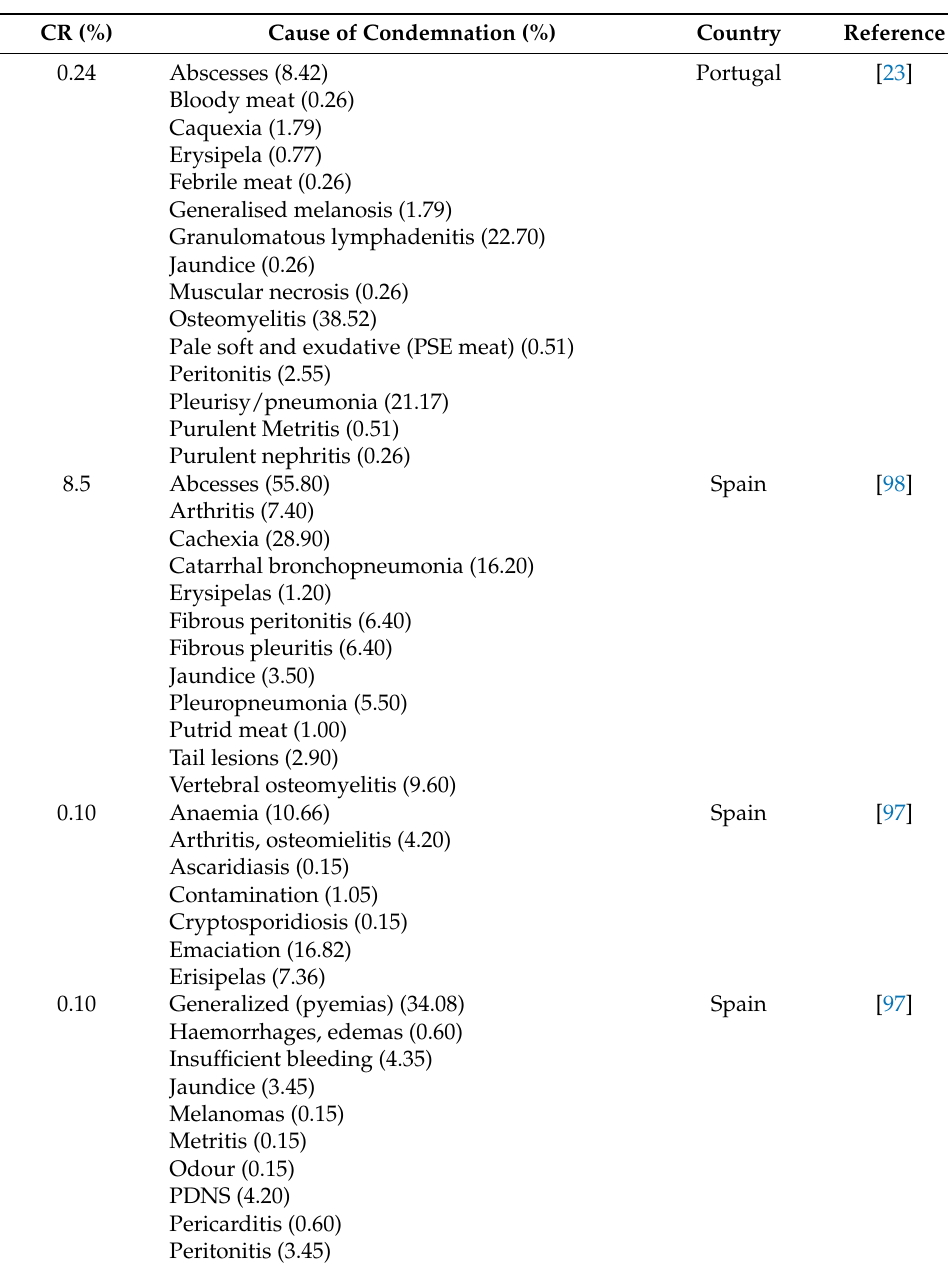
Table 6. Causes of pig carcass